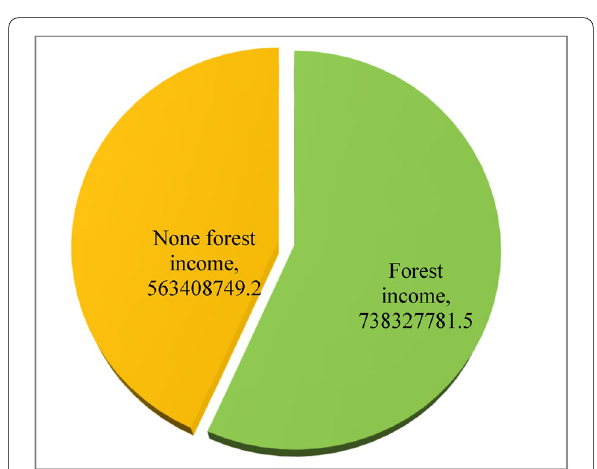
Fig. 4 Contribution of income source (ETB)